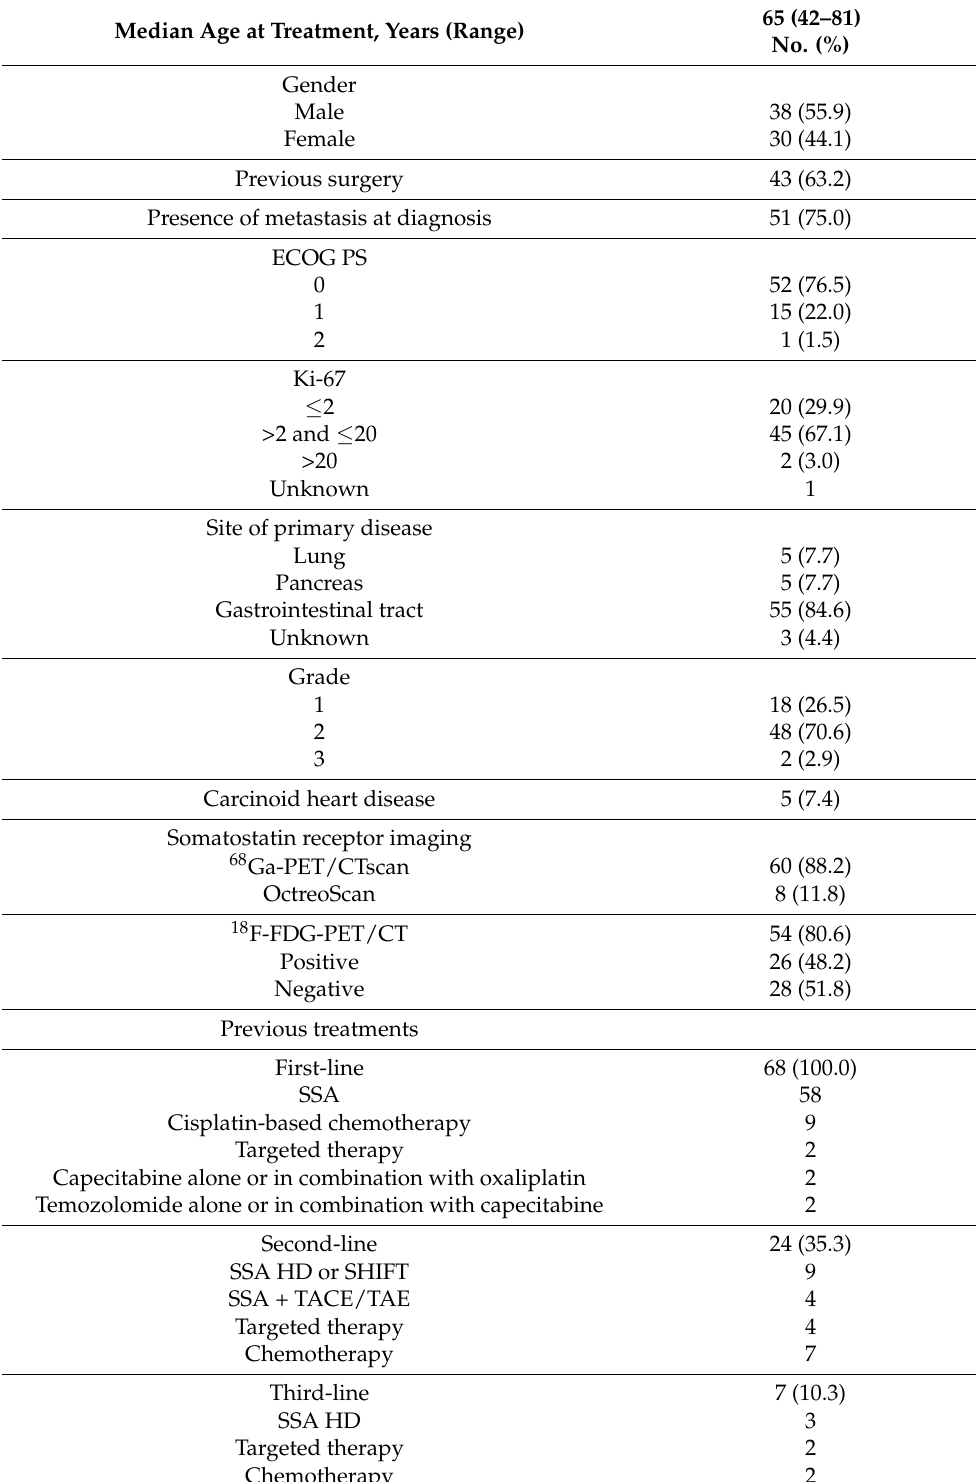
Table 1. Main patient